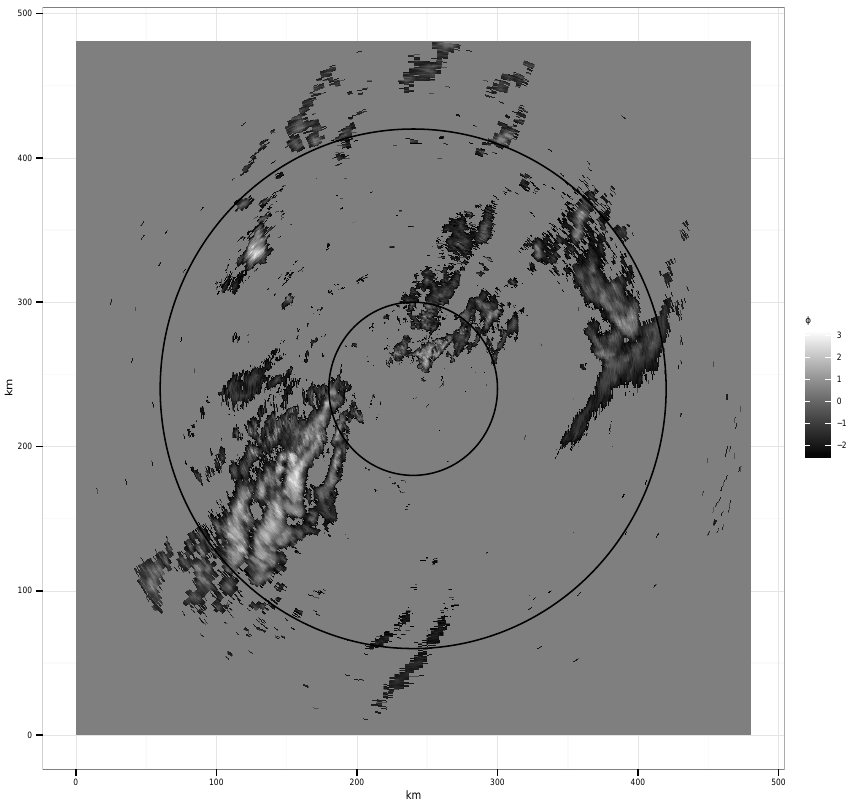
Figure 2. A log-transformed rainfall field, together with the radius of reliable observations (circles) at 60 km and 180 km.